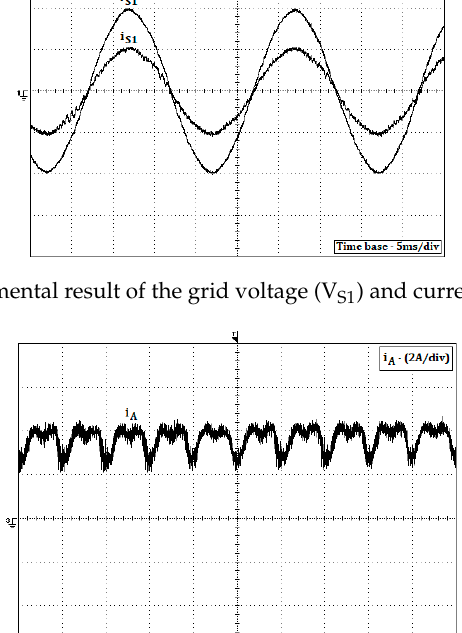
Figure 14. Experimental result of the grid voltage (V S1 ) and current in phase 1 (i S1 ).